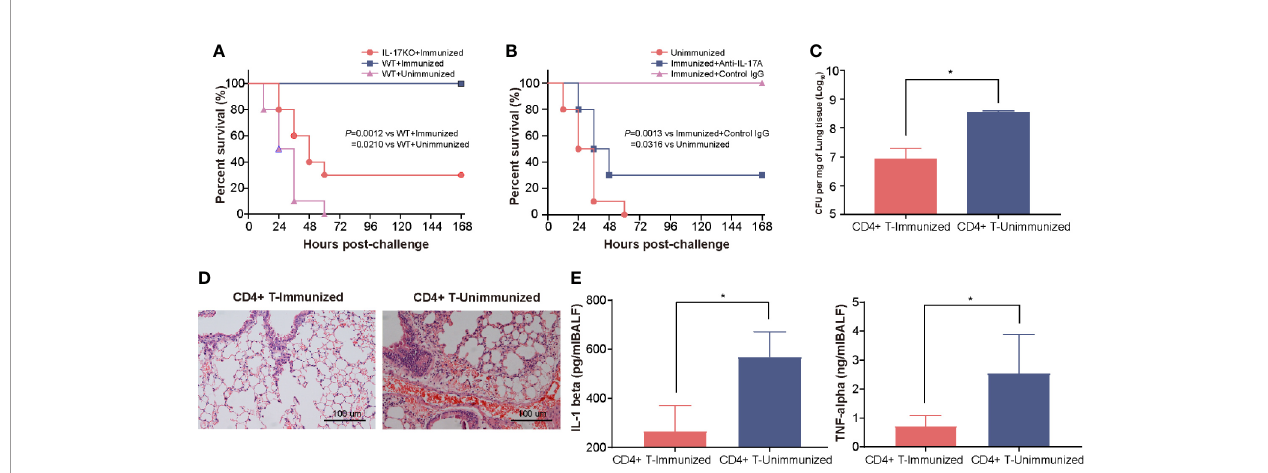
FIGURE 3 | The enhanced protection of intranasal vaccination with rePcrV depends on the Th17 response. (A) WT (wild-type) mice or IL-17A knockout mice (n = 10) were immunized with rePcrV and then intratracheally challenged with a lethal dose of PA XN-1. The bar represents the survival of the mice in each group. (B) WT mice were immunized with rePcrV and administered anti-IL-17A antibodies (n = 10) and with isotype control IgG as a control. The bar represents the survival rate of the two groups at each observation point. (C) CD4+ T cells from the lungs of rePcrV-immunized mice were transferred into naïve WT mice. Then, the mice were challenged with a sublethal dose of PA XN-1. The bar represents the average and SE of the log CFU of PA XN-1 per mg of lung tissue (n = 4). (D) HE staining of the lungs of mice after infection with a sublethal dose of PA XN-1. Images were captured at 100× magni fi cation. (E) Quantitative measurement of TNF- a and IL-1 b in the BALF of mice (n = 3). The data are shown as the mean ± SE. The “ * ” indicates a signi fi cant difference at P <